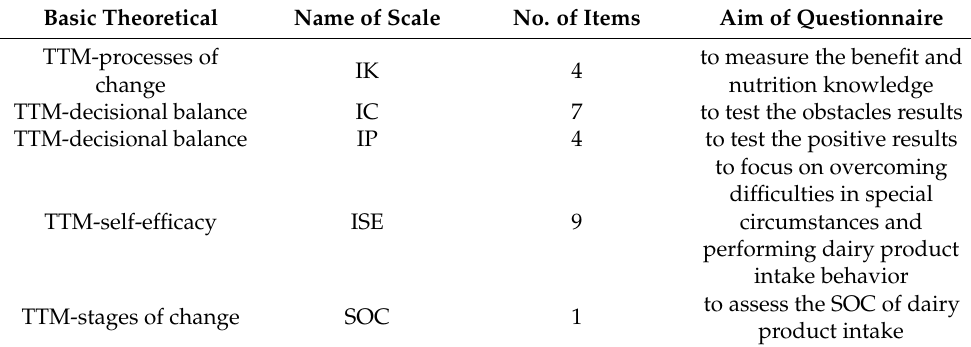
Table 1. Characteristics of